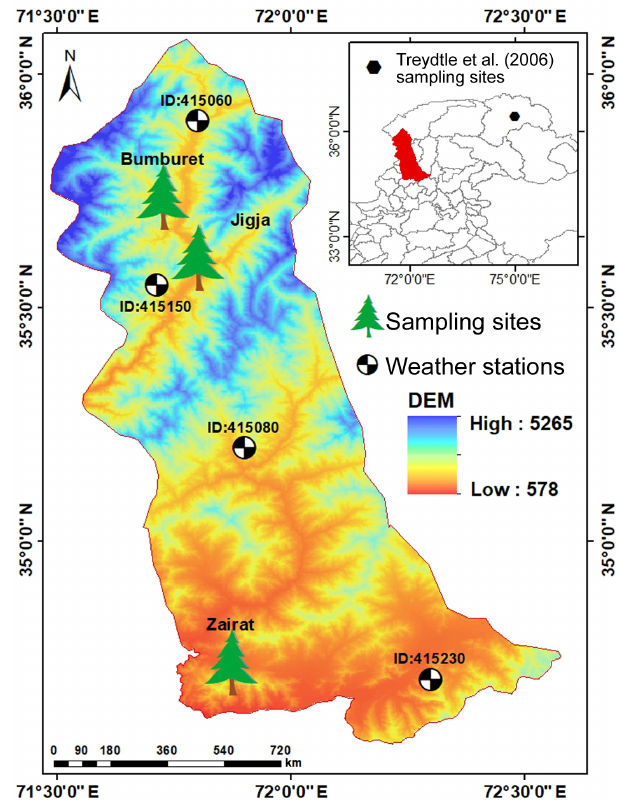
Figure 1. Map of the weather stations (Drosh station) and sampling sites in the Chitral, Hindu Kush mountains, Pakistan. Different col- ors represent the elevation changes in the study